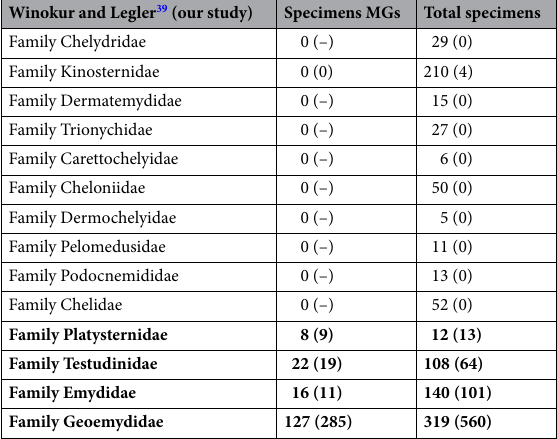
Table 1. Results of surveys for mental gland (MG) status for all extant turtle families from Winokur and Legler 39 and this study (in brackets). Families in which MGs were found are highlighted in bold. All examined specimens from both studies are